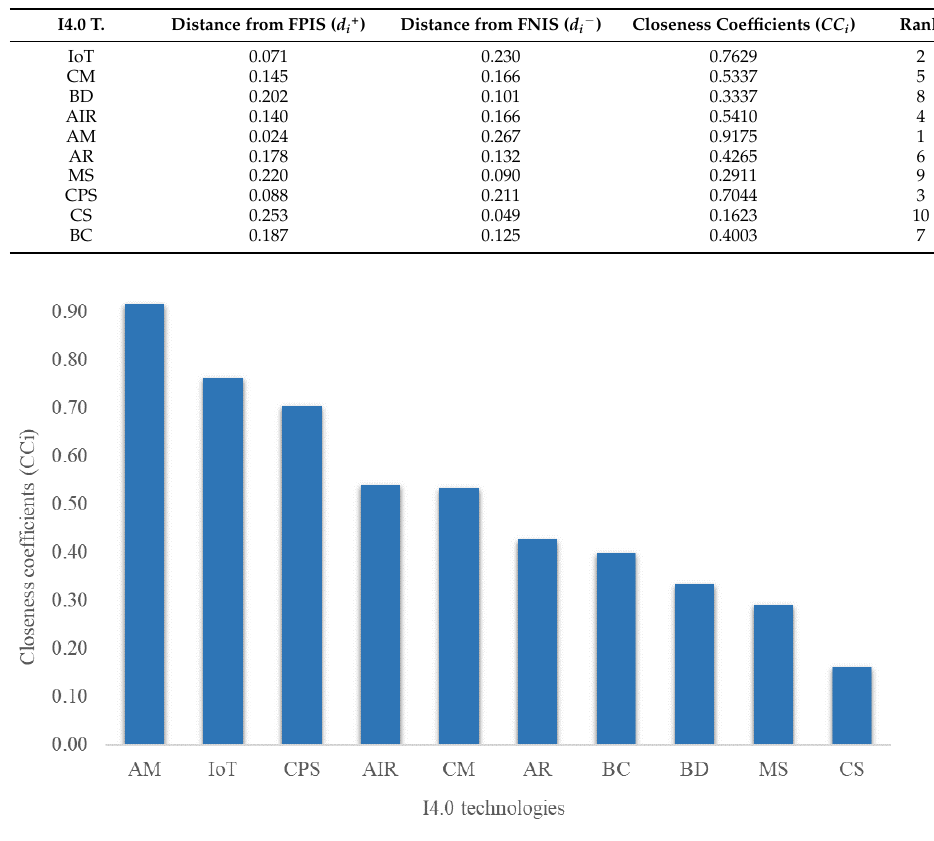
Figure 5. Ranking of I4.0 technologies.